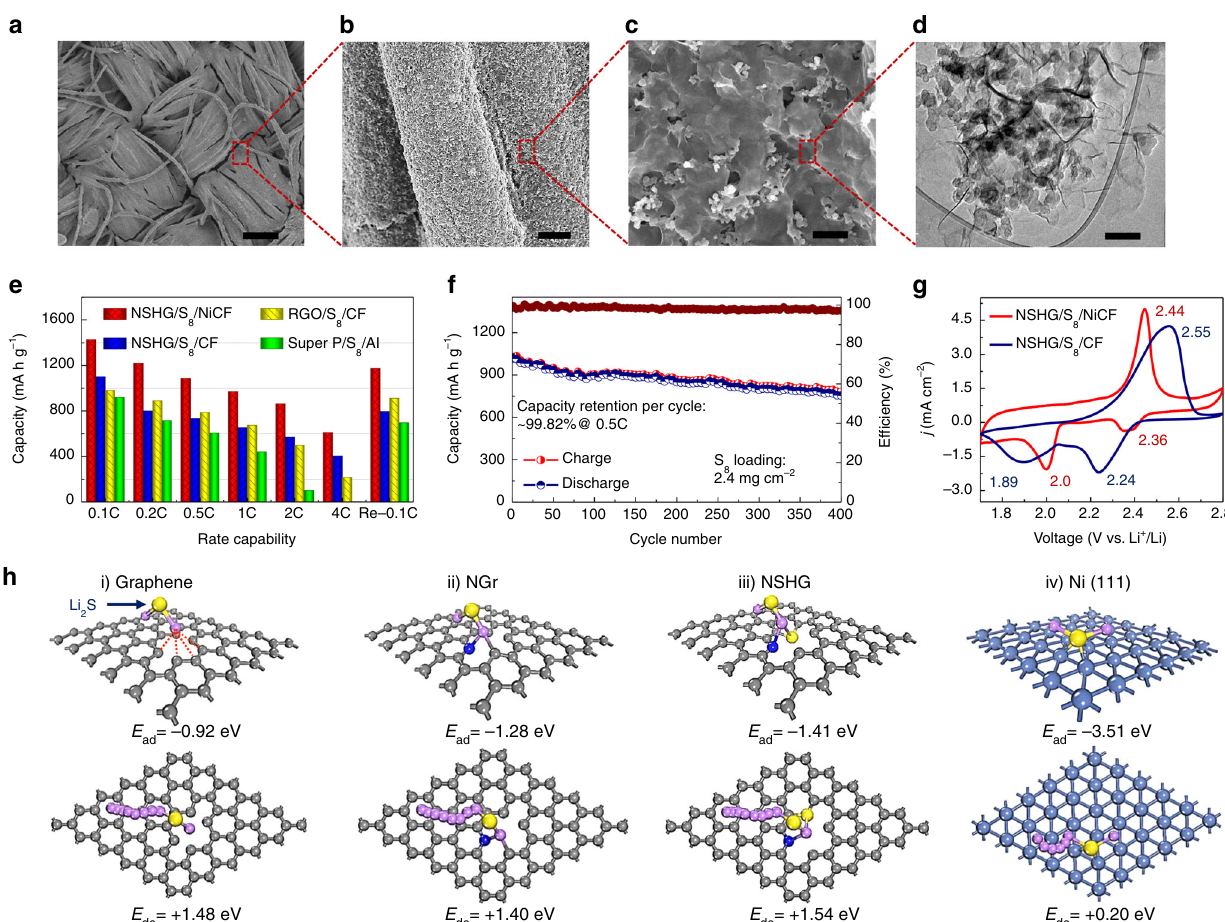
Fig. 4 Cycling stability and rate capability of sulfur cathode. a – c Low and high magni fi cation scanning electron microscopy (SEM) images of the NSHG/S 8 / Ni cathode (NSHG is nitrogen and sulfur heavily doped graphene). The sulfur cathode was obtained by direct in fi ltration of NSHG/S 8 hybrid inks into the nickel-deposited carbon fabric (NiCF), followed by drying at 60 °C in a vacuum chamber. Scale bar for a – c is 100 µ m, 5 µ m, and 500 nm, respectively. d Transmission electron microscopy (TEM) images of NSHG/S 8 cladding layers, extracted from NSHG/S 8 /Ni cathode (scale bar = 200 nm). e Speci fi c capacities at various rates for sulfur cathodes, including NSHG/S 8 /NiCF, NSHG/S 8 /CF (CF is carbon fabric), RGO/S 8 /NiCF (RGO is reduced graphene oxide) and Super P/S 8 /Al electrodes (Super P is a type of carbon black). f Speci fi c capacities, and corresponding CE values of the optimized NSHG/S 8 / NiCF cathode were obtained at 2 mA cm − 2 for 400 cycles. g Cyclic voltammetry curves of NSHG/S 8 /NiCF and NSHG/S 8 /CF at a scan rate of 0.2 mV s − 1 in a potential window from 1.7 to 2.8 V. h Theoretical calculation of the adsorption and decomposition energies of Li 2 S on the surface of RGO, nitrogen- doped graphene (NGr), NSHG, and the thin slab of Ni (111). Notably, the thin slab of Ni (111) with a large adsorption energy of − 3.51 eV and a